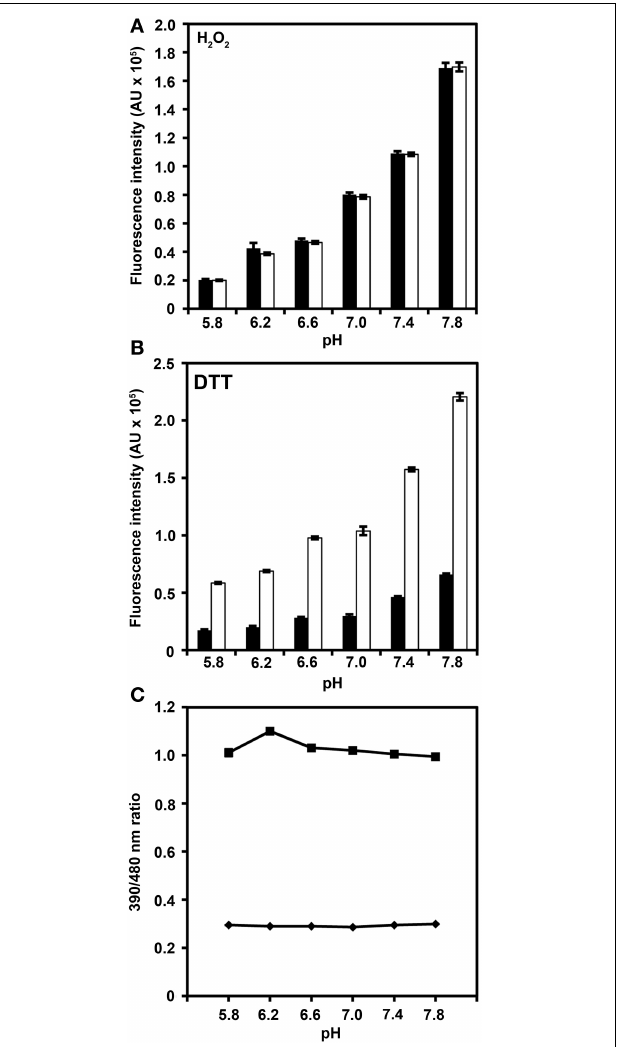
FIGURE 3 | pH-dependence of roGFP2-iL fluorescence. Recombinant roGFP2-iL was incubated in potassium-phosphate buffer at different pH values. The changes in roGFP2-iL fluorescence intensity of the 390nm (black) and 480nm channel (white) in buffers of different pH values under full oxidation with 10mM H 2 O 2 (A) and full reduction by 10mM DTT (B) is shown. Increasing pH values beyond pH 7.0 equally increase fluorescence intensity in both channels thus the 390/480nm ratio remains unaffected. Conversely, decreasing pH below pH 7.0 has the opposite effect for fully oxidized and fully reduced roGFP2-iL. Similar pH-dependent effects have been reported for wild-type GFP (Patterson et al., 1997). (C) The excitation ratios (390/480nm) in 10mM H 2 O 2 ( (cid:2) ) and in 10mM DTT ( (cid:3) ) of roGFP2-iL are plotted against the respective pH solution. For several data points, standard error is smaller than data marker ( n = 3 technical replicates).